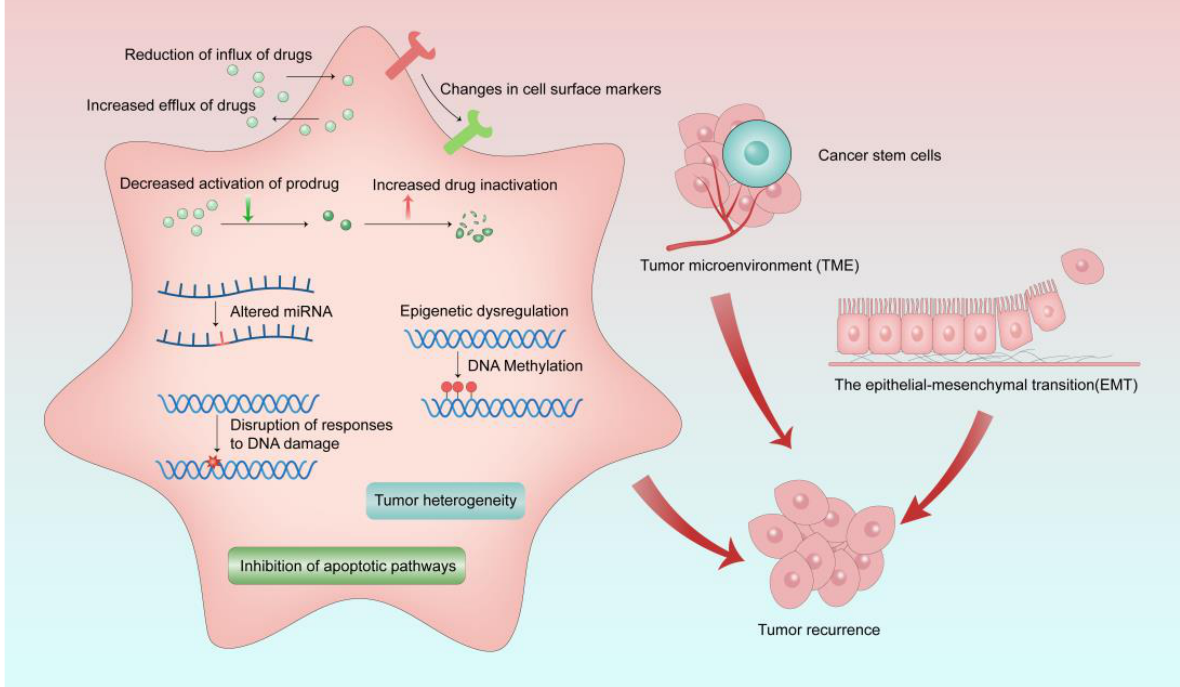
Figure 2. Mechanisms of MDR in cancer treatment. MDR occurs as a result of various causes, which ultimately lead to tumor recurrence.